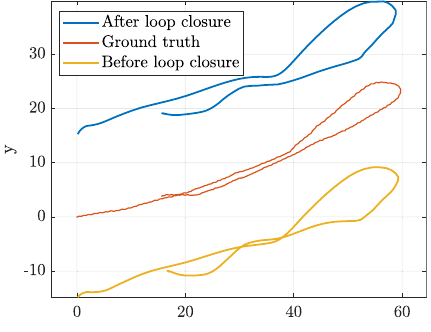
Fig. 8 Exhaustive parameter search, to evaluate the effect of certain parameters against performance metrics obtained from ground truth. The error values shown above, are the lowest error